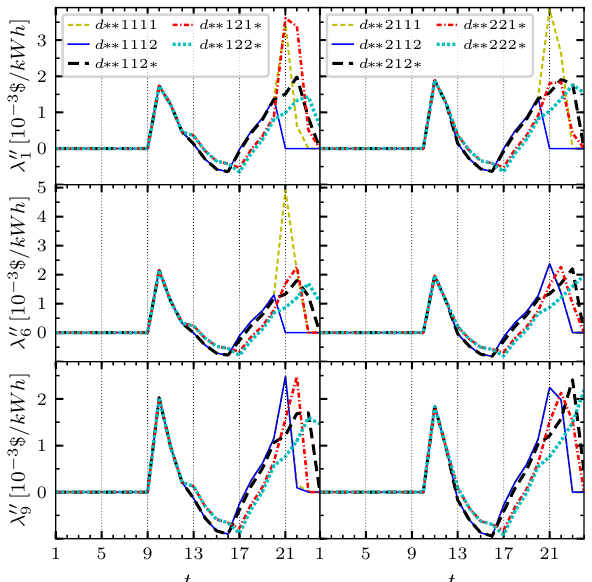
Figure 6. Personalized taxes/incentives λ (cid:48)(cid:48) n for players 1, 6, and 9 and for 10 different scenarios. In the legend, asterisks “ ∗ ” denote time intervals during which, for the scenario in question, the value of λ (cid:48)(cid:48) n ( k t ) is independent of the non-PEV demand realization d ( k t ) .